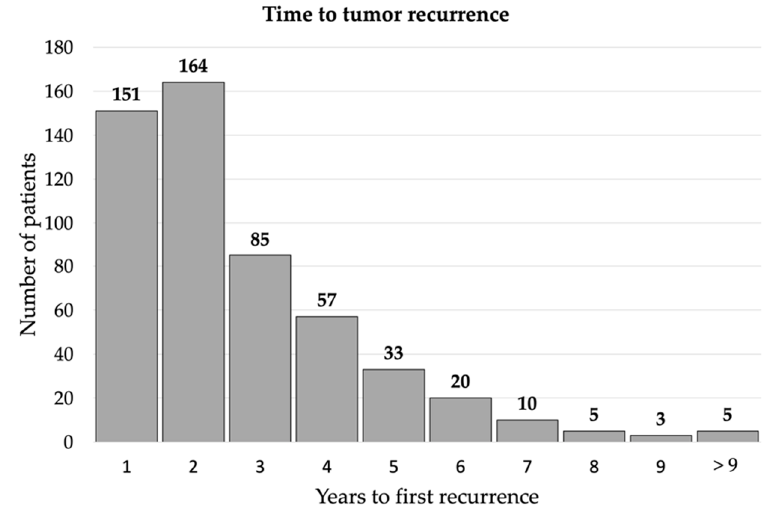
Figure 2. Time distribution of tumor recurrence: 315 (59.1%) patients had recurrence within 2 years,